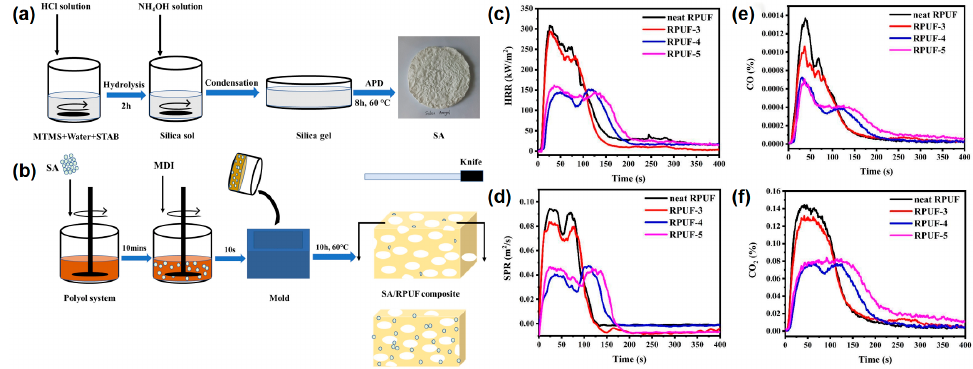
Figure 5. ( a ) The schematic diagram of the SA manufacturing process; ( b ) the preparation route of SA-coated RPUF, ( c ) HRR, ( d ) SPR, ( e ) CO, and ( f ) CO 2 curves in the cone test of pure RPUF and SA-coated RPUF [47].